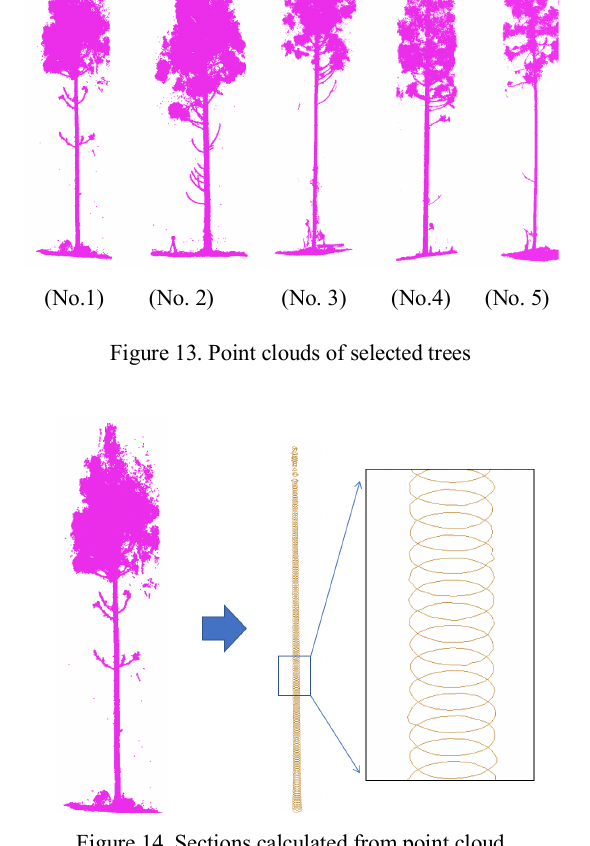
Figure 14. Sections calculated from point